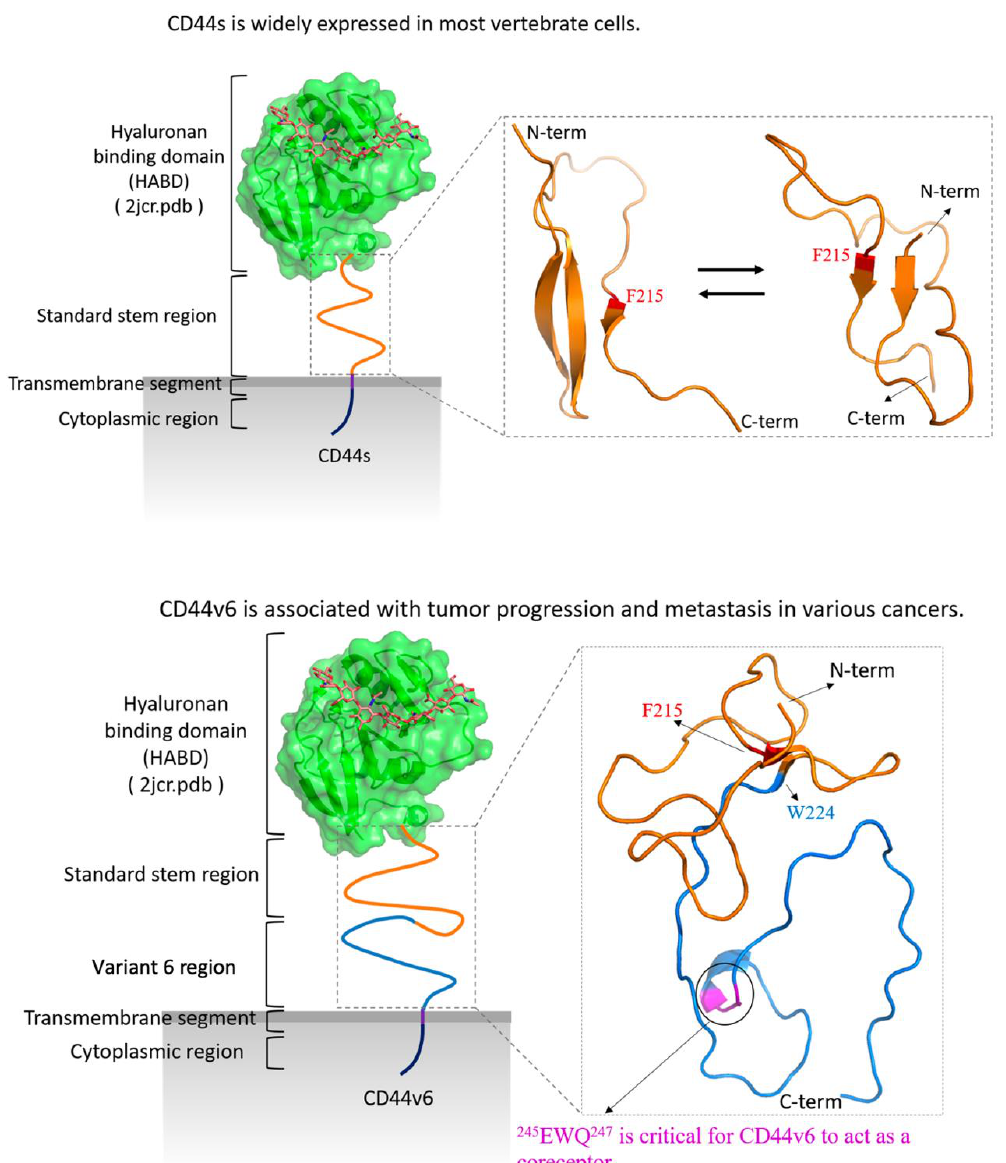
Figure 8. Schematic for the molecular structures and biological characteristics of CD44s (top) and CD44v6 (bottom). The structure of the HABD (hyaluronan-binding domain) was retrieved from the Protein Data Bank (PDB) (ID: 2JCR), and hyaluronan is shown in sticks. The identified key residue Phe215 is colored red in both CD44s and CD44v6. The standard stem region is colored orange, and the v6 region is colored blue. The amino acids (AAs) 245EWQ247, which are required for CD44v6 to act as the coreceptor for receptor tyrosine kinases (RTKs), including c-Met, Ron, and VEGFR-2, are colored